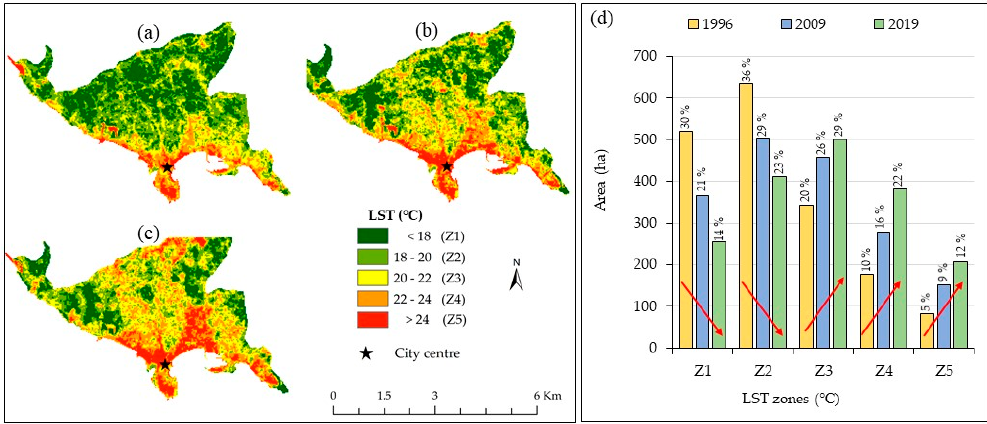
Figure 3. Land surface temperature (LST) map of GMC area: ( a ) LST in 1996, ( b ) LST in 2009, ( c ) LST in 2019, and ( d ) spatiotemporal variation of LST by zones.